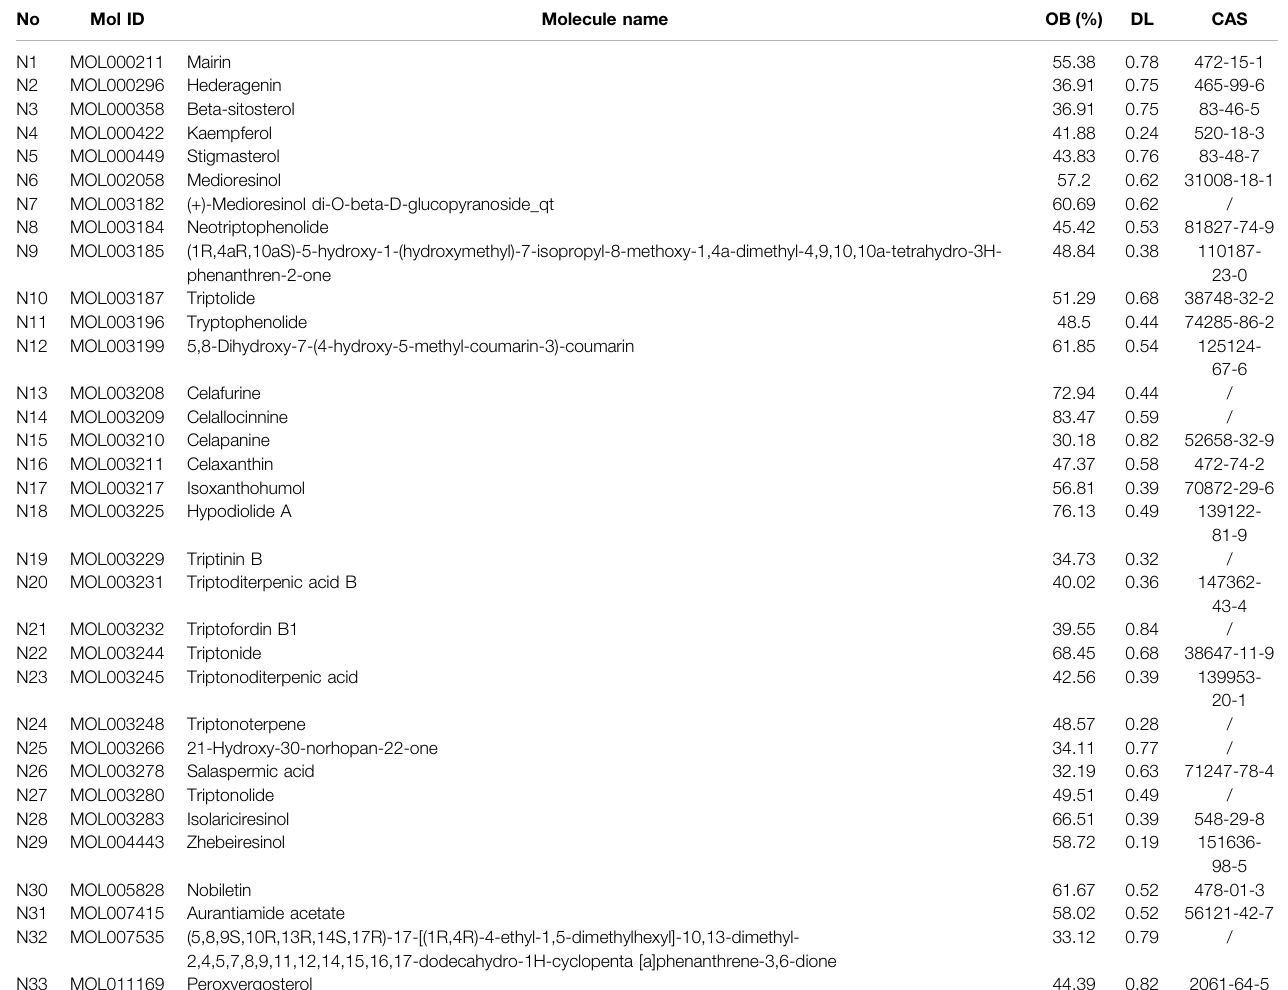
TABLE 1 | Active components with OB ≥ 30% and DL ≥